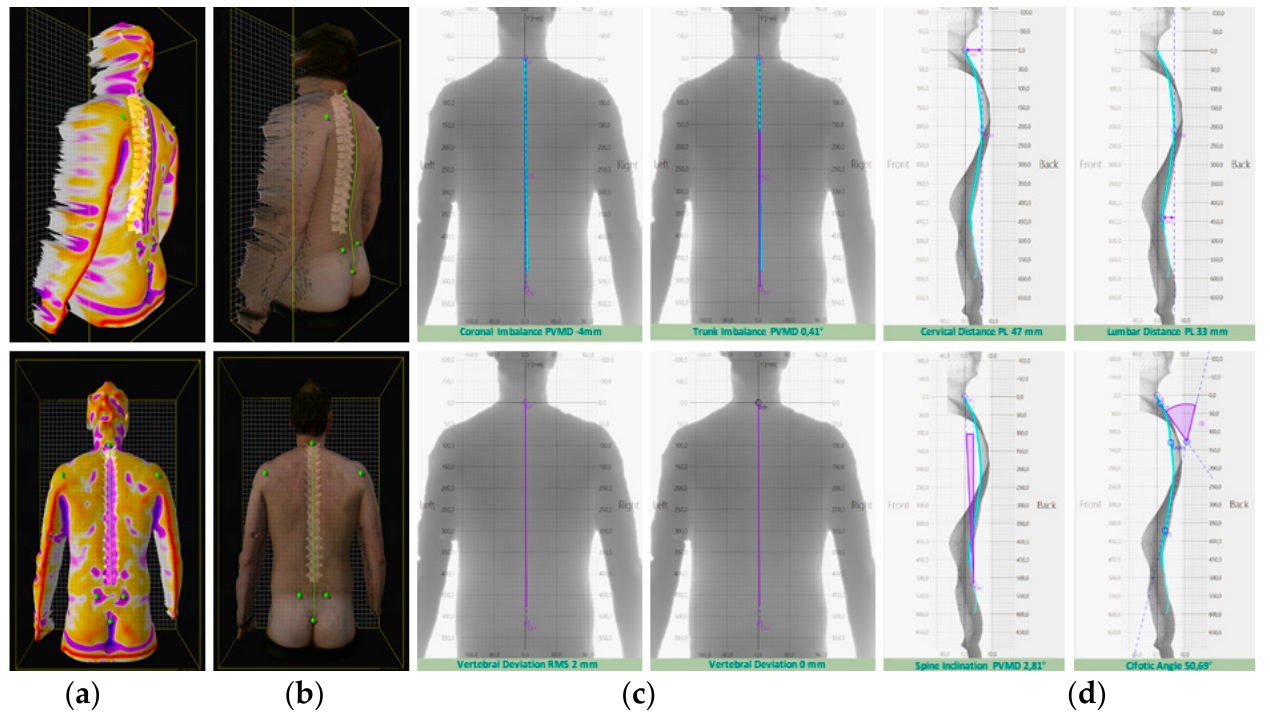
Figure 3. Spine rasterstereography accomplished through the Spine3D system. ( a ) represents the 3D reconstruction of back concavities. ( b ) represents the spine reconstruction over the patient’s spine photo. ( c ) represents the coronal plane measurements. ( d ) represents the sagittal plane measure ‐ ments.